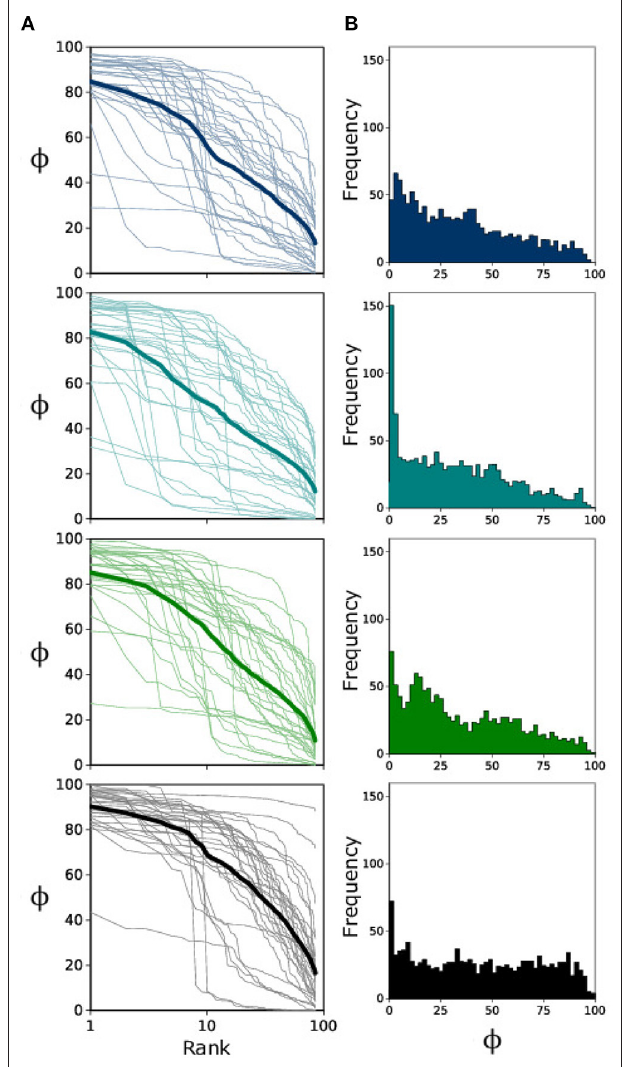
FIGURE 2 | (A) Semi-log plot of Rank-Size Distribution for all landscape replicates ( n = 30) in light color and the ensemble average in bold. Occupancy ranges from 0 to 100%. (B) Occupancy frequency histogram for individual patches ( n =